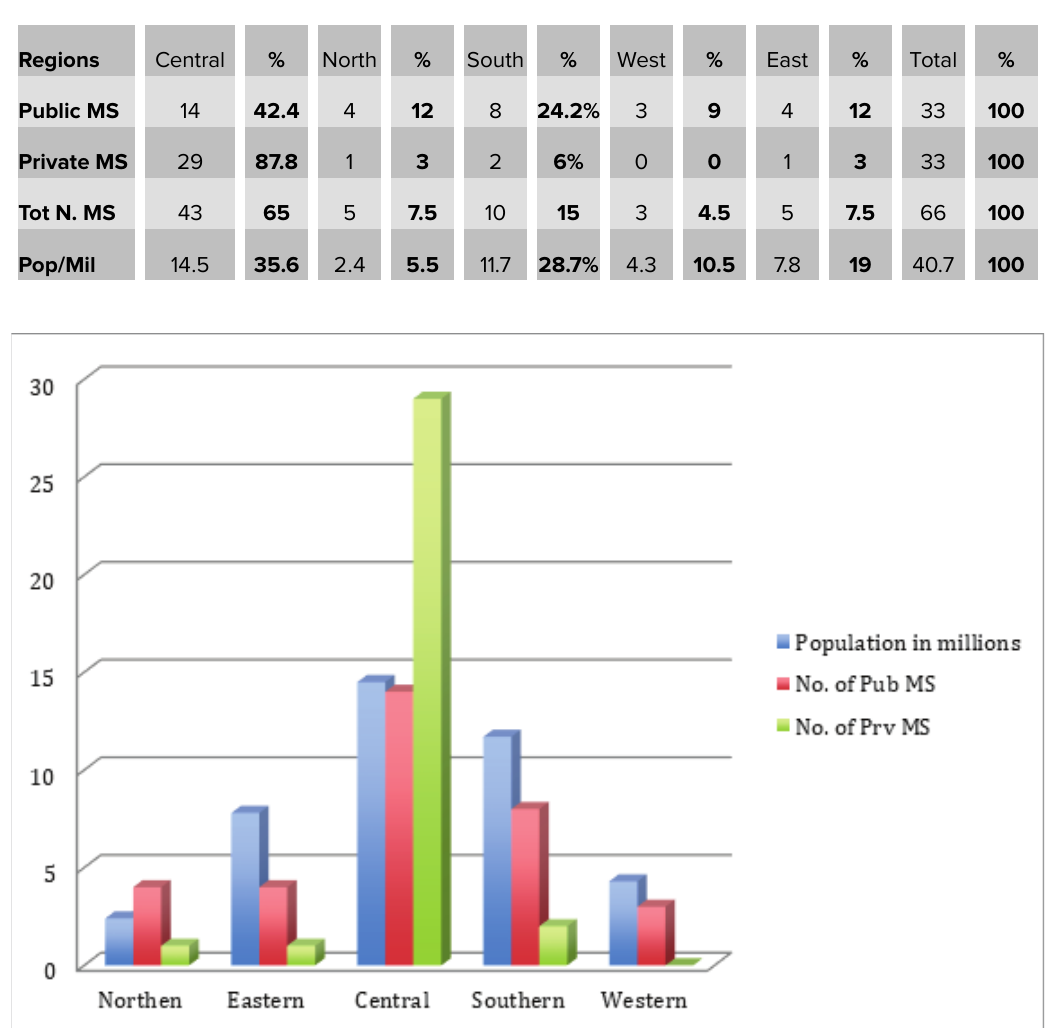
Table 1: Distribution of Medical Schools/Region.